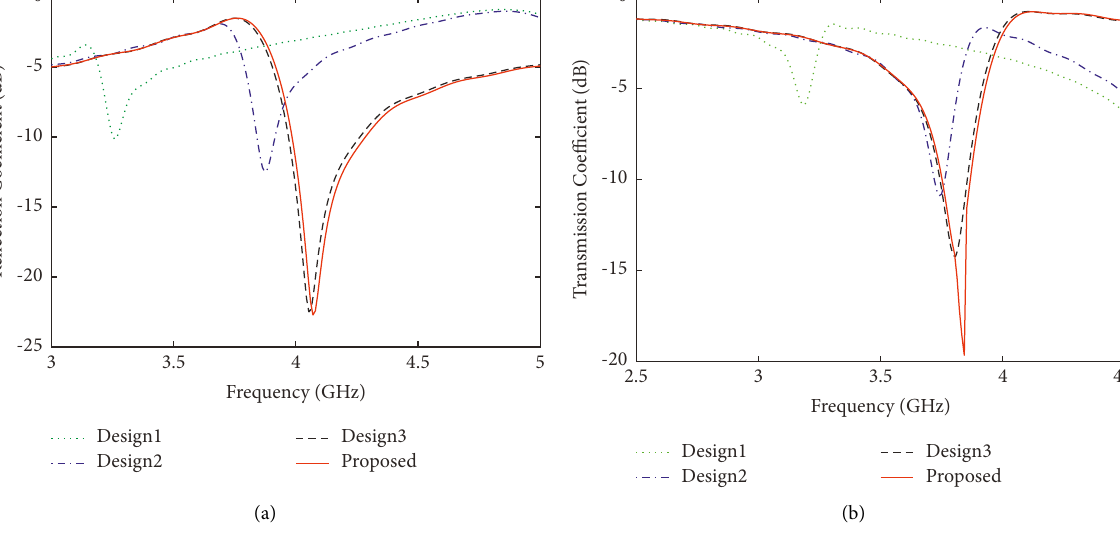
Figure 3: Parametric analysis of the proposed MTM unit cell; (a) reflection coefficient and (b) transmission